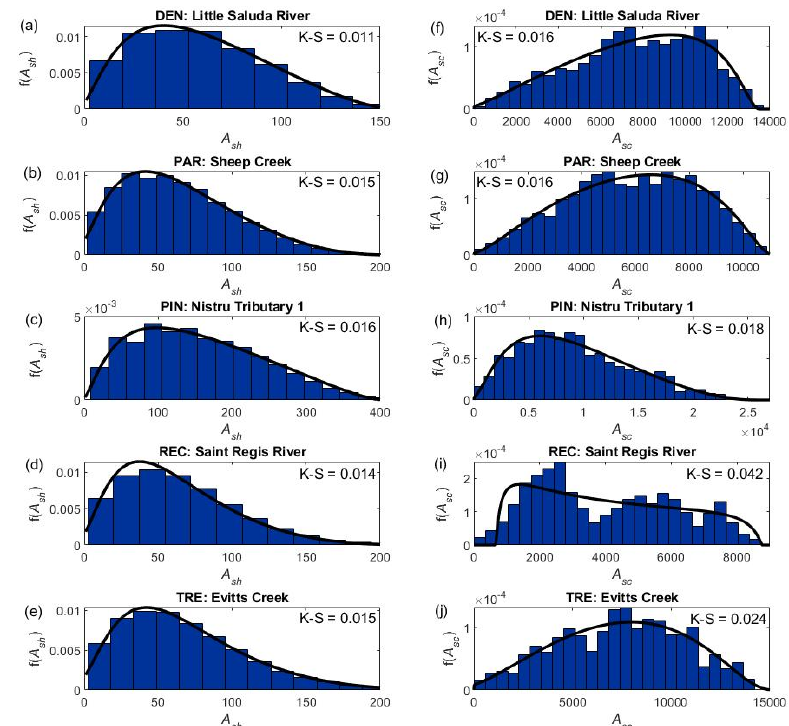
observed relationships can be approximated with power functions. The power functions may differ Figure 3. Histograms and fitted Johnson SB distributions for A sh ( a–e ) and A sc ( f – j ) for an example between certain network types. Specifically, the power function for pinnate basins is much higher Figure 3. Histograms and fitted Johnson SB distributions for sh A ( a–e ) and sc A ( f–j ) for an example than the power function for rectangular basins. basin of each type. The basins are the same as those in Figure 1. basin of each type. The basins are the same as those in Figure 1.